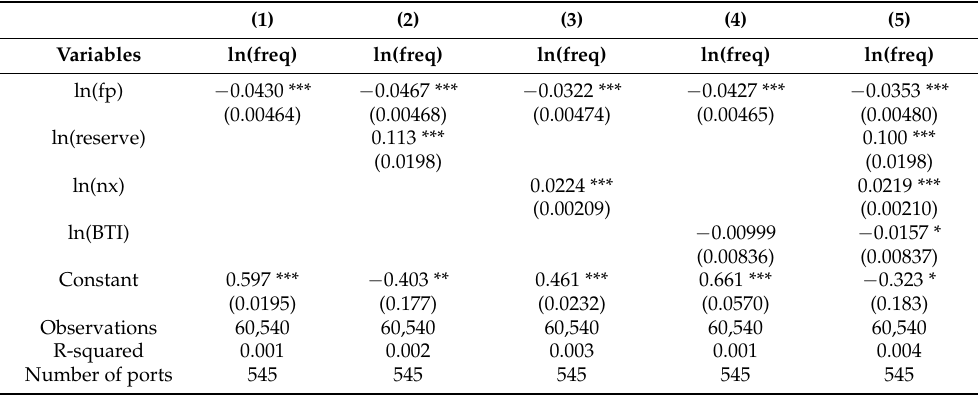
Table 3. Results of fixed-effect regression